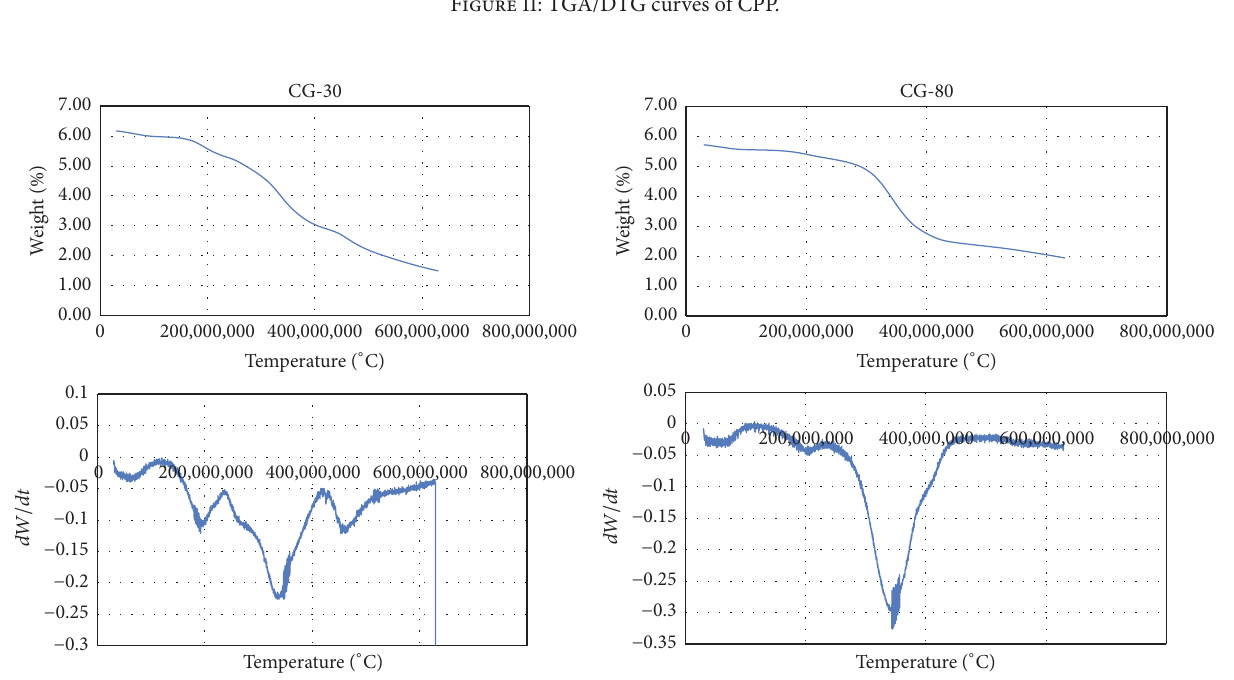
Figure 12: TGA/DTG curves of CG-30 and